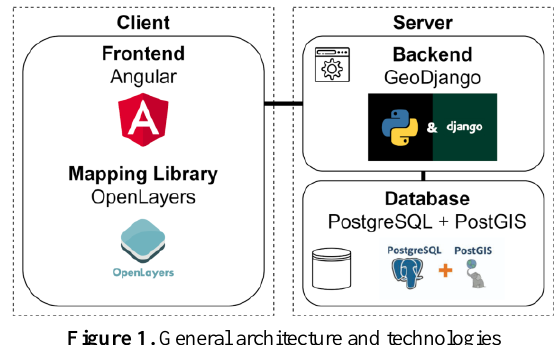
Figure 1. General architecture and technologies